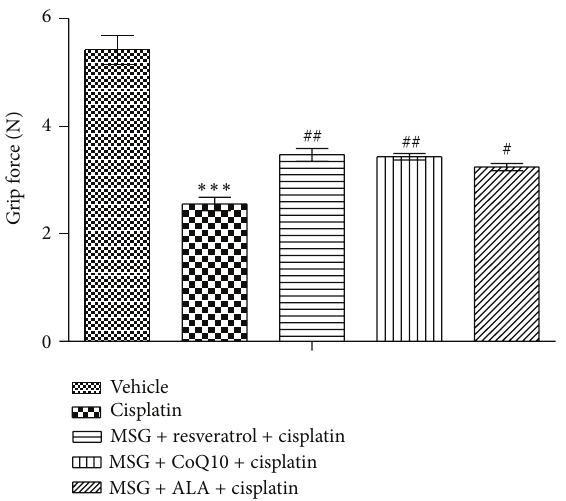
Figure 6: Effect of chronic treatment with combination of MSG and resveratrol/ALA/Co Q10 on nerve conduction velocity in sciatic nerve of cisplatin treated rats. ∗∗∗ ( 𝑃 < 0.001 ) versus control group, # ( 𝑃 < 0.05 ), ## ( 𝑃 < 0.01 ) versus cisplatin treated group.